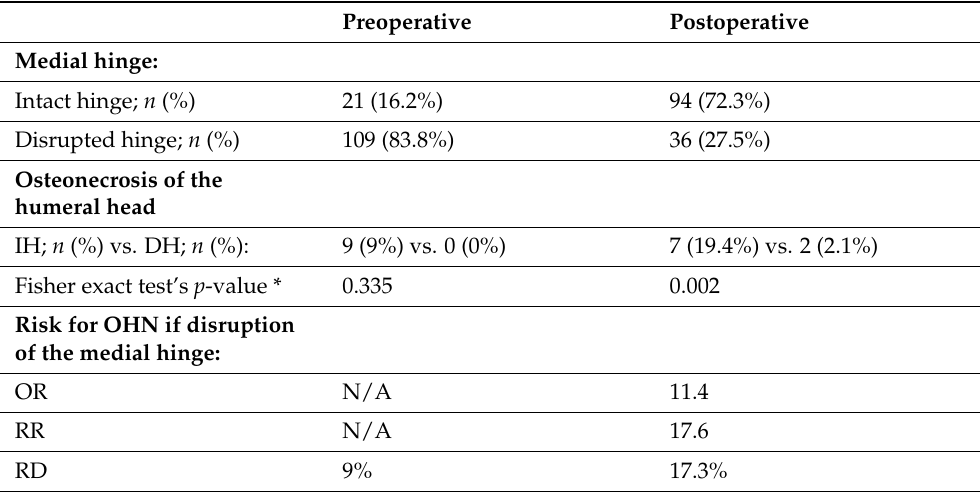
Table 6. Incidence of osteonecrosis of the humeral head (OHN) in cases of preoperative disruption of the medial hinge and of no operative reconstruction; IH = intact hinge, DH = disrupted hinge, OR = odds ratio, RR = relative risk, RD = risk reduction. Preoperative